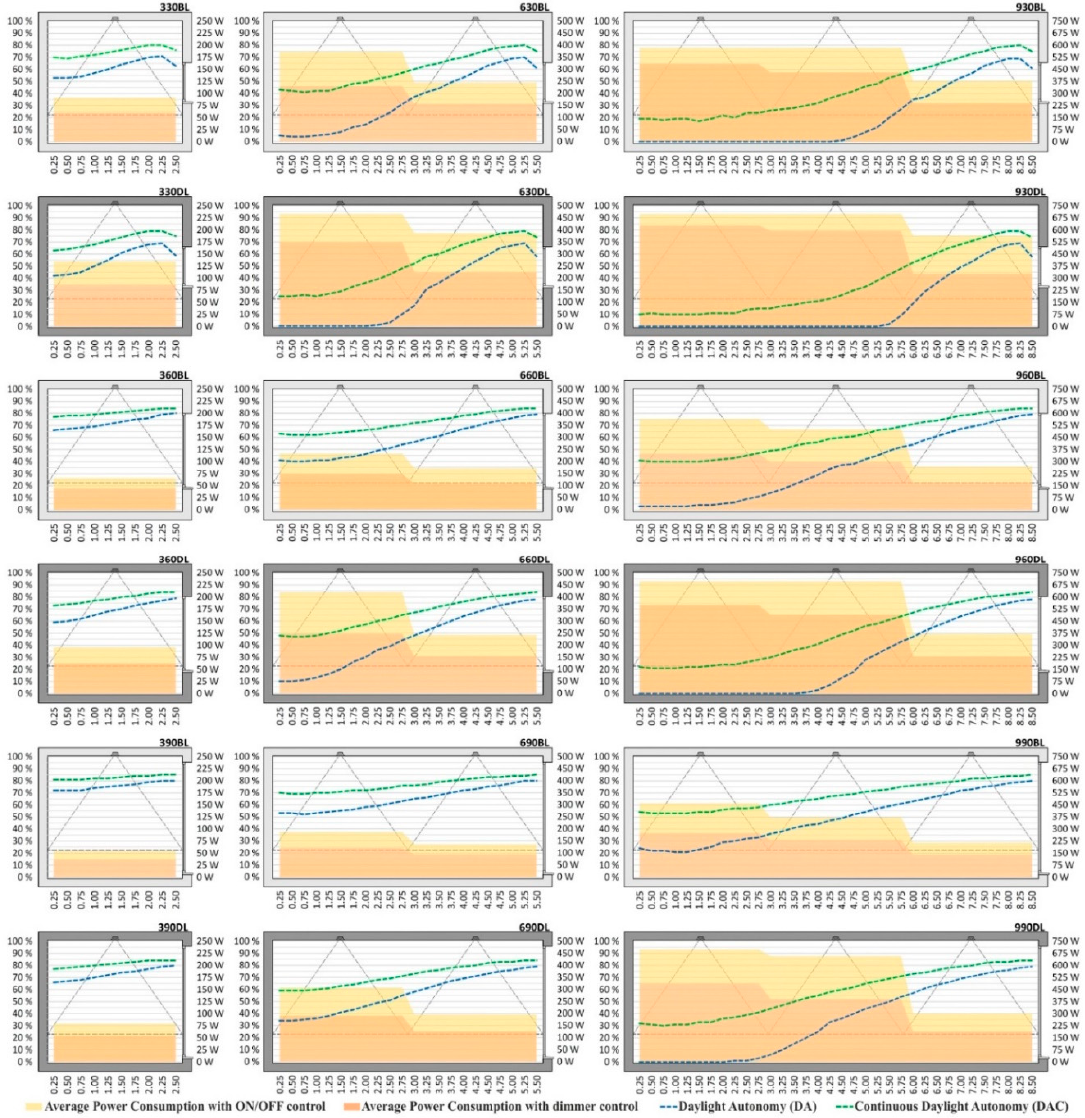
Figure 5. Daylight dynamic metrics and average power consumption according to different smart controls for room models located in London.